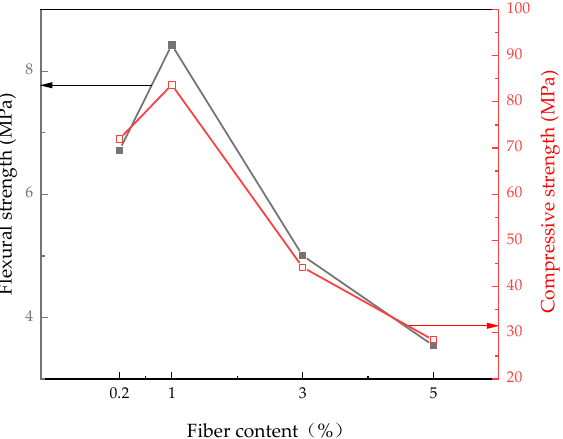
Figure 12. Mechanical strengths of alkali-activated BFS with different dosages of fibers.